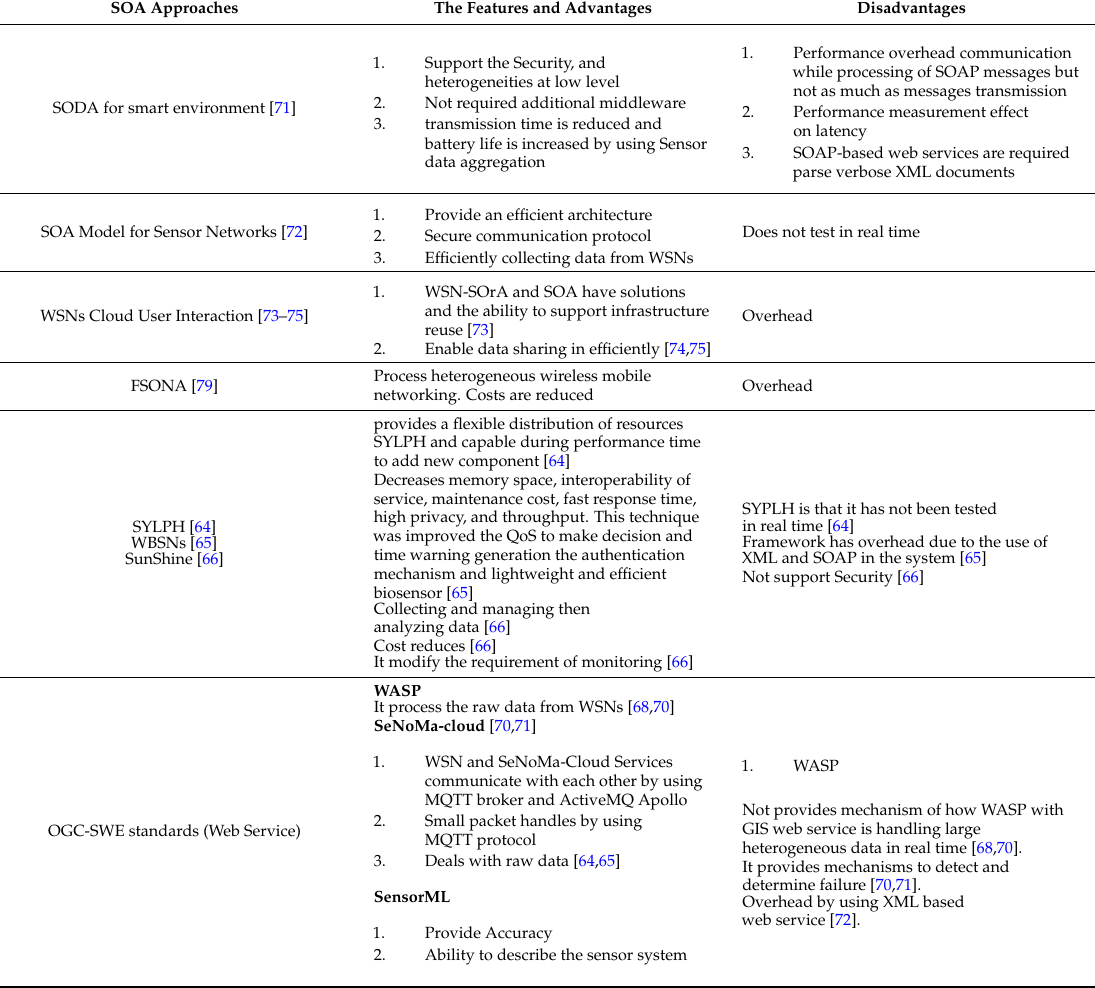
Table 6. Advantages and Disadvantages of SOA for